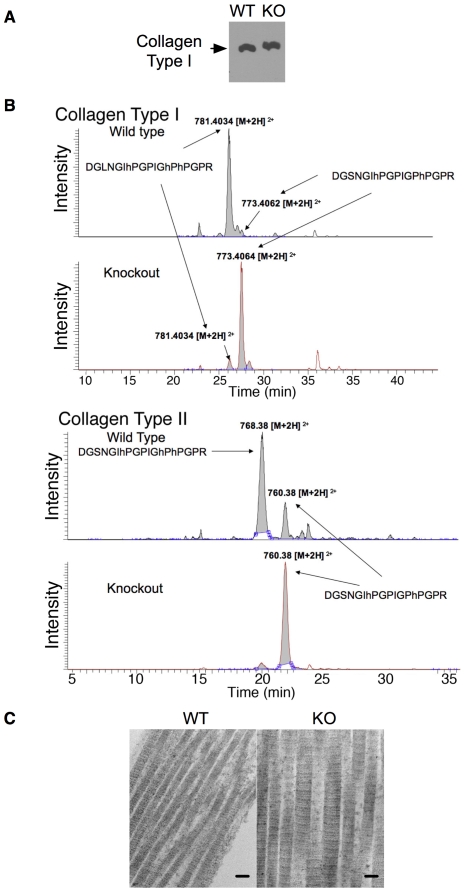
Altered collagen in CypB–knockout mice.(A) Skin fibroblasts from wild-type or CypB knockout mice were cultured in serum free medium. Secreted collagen from the supernatant was electropheresed on 5% SDS-PAGE and detected by Western Blotting. Type I collagen from mutant animals demonstrated a subtle but reproducible decrease in migration compared to wild type. (B) Mass-spectroscopic analysis of type I and type II collagen from bone and cartilage. Chromatogram of the parent ions in the mass spectra from wild type and Ppib−/− collagen tryptic-peptides. Wild-type collagen is 4-hydroxylated at pro-981 and pro-987, and 3-hydroxylated at pro-986. Collagen from Ppib−/− mice primarily lacked the pro-986 hydroxylation. Indicated peaks were analyzed by MS2 and MS3 to identify hydroxylated proline residues (‘hP’). (C) Transmission electron micrographs of subcutaneous tissue revealing abnormally thick collagen fibrils in mutant mice in comparison to control mice. (bar = 100 nm).